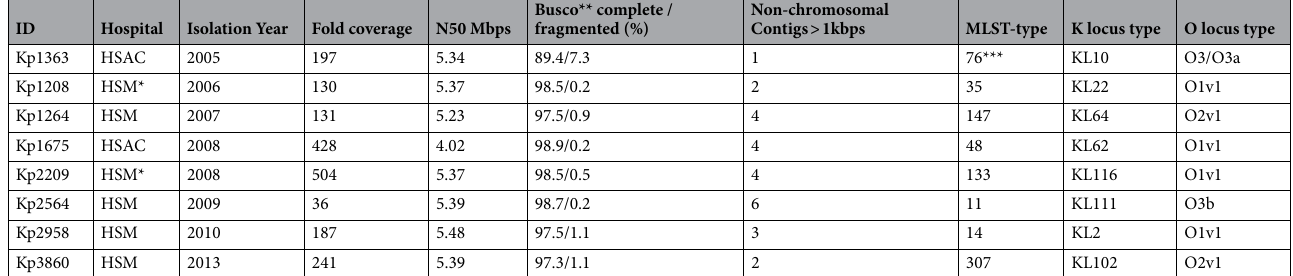
Table 1. Klebsiella pneumoniae assemblies generated for the analysis. All isolates sourced from blood, except * from urine; HSM Hospital de Santa Maria; HSAC Hospital St Antonio dos Capuchos; MLST sequence